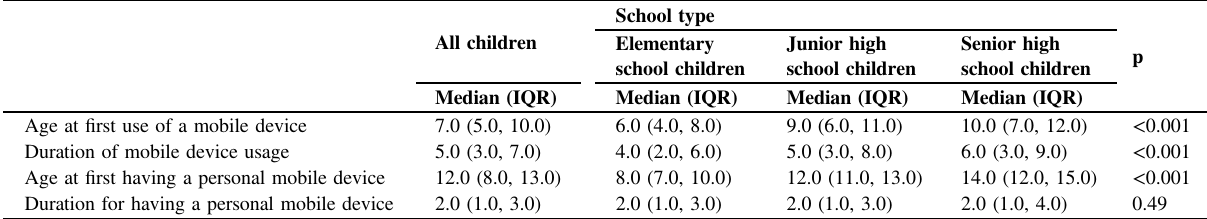
Table 2 Child ’ s age at fi rst use of a mobile device and the duration of use.